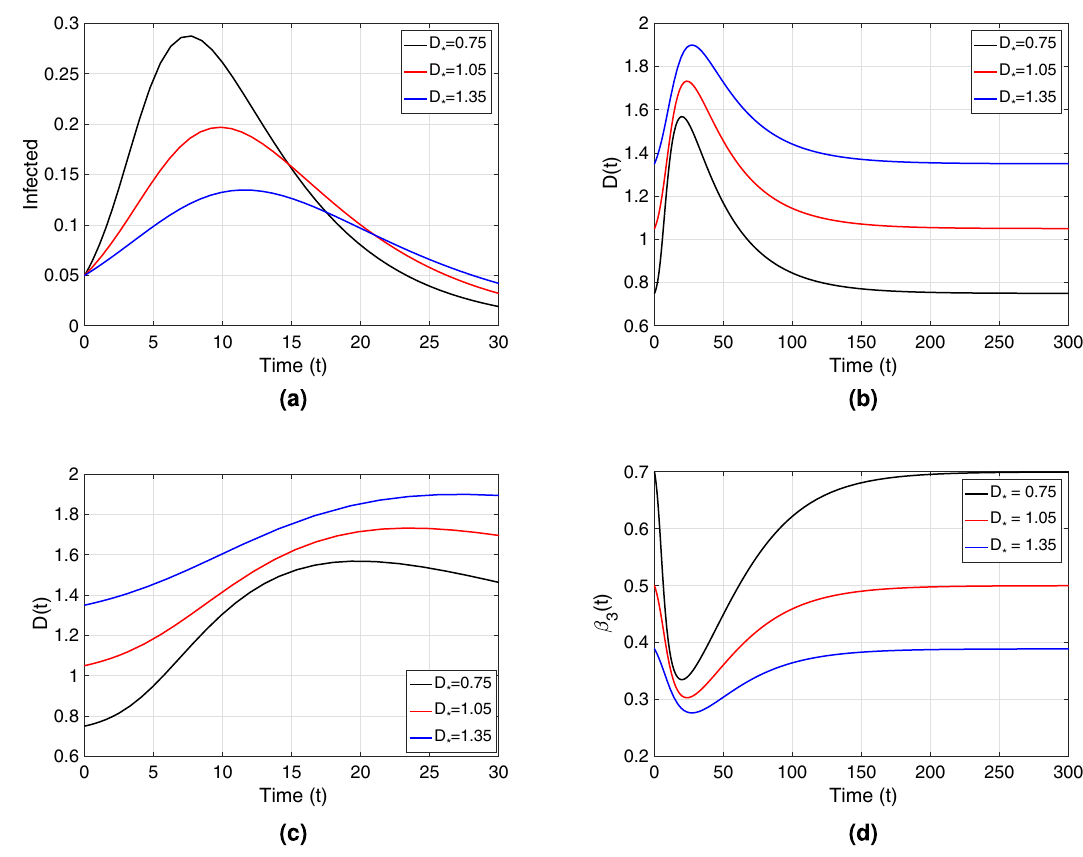
Figure 6. ( a ) Point prevalence, I ( t )/ N , from the system in Eq. (1) with respect to time. ( b ) Distance D ( t ) kept by individuals through the epidemic. ( c ) Zoomed version of ( b ). ( d ) Transmission rate β 3 ( t ) = β 3 ( D ( t )) from Eq. (8). All plots in the figure consider β 3 ( D ) as the transmission rate. Black, red and blue curves correspond to D ∗ = 0.75 ( m ) , D ∗ = 1.05 ( m ) , and D ∗ = 1.35 ( m ) respectively. These correspond to societies of small ([0, 100)), medium ([100, 120]) and large ( [ 120, ∞ ) ) natural-distance types respectively (see Table 1). The other parameter values were taken to be β ∗ = 0.5 ; γ = 0.2 , ν = 1 , (cid:31) 1 = 0.03 , (cid:31) 2 = 0.3 . The R 0 value for each society type is: R 0 = 3.5 (black), R 0 = 2.5 (red), R 0 = 1.9 (blue). The initial condition D ( 0 ) = D ∗ was used for each type of